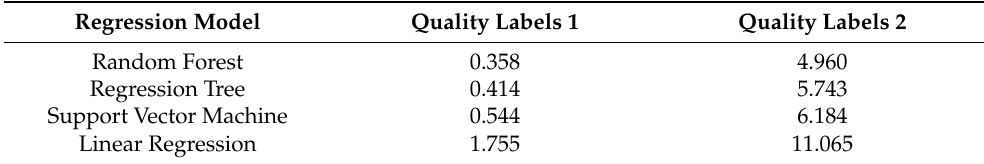
Table 5. Bench-marking of regression models in MATLAB’s regression learner app. Quality Label columns represent the achieved Root Mean Square Error (RMSE) for the labels used from the two approaches in training the